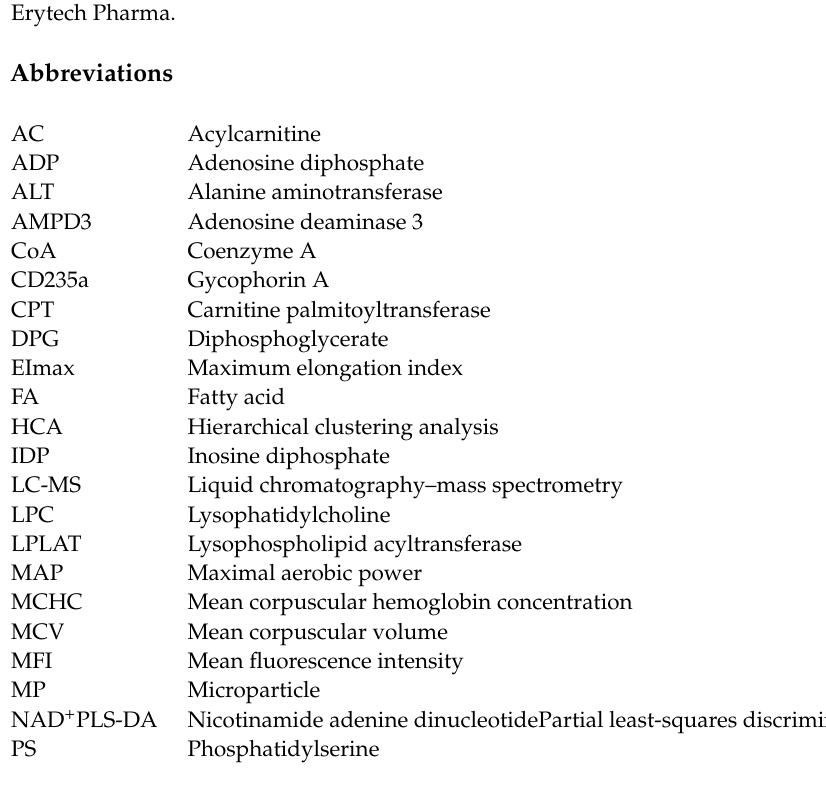
Figure S2. Hierarchical Clustering Analysis of Plasma and RBC Metabolites; Figure S3. Body Weight and Metabolite Signal as a Function of Cycling Exercise; Table S1. Metabolomics